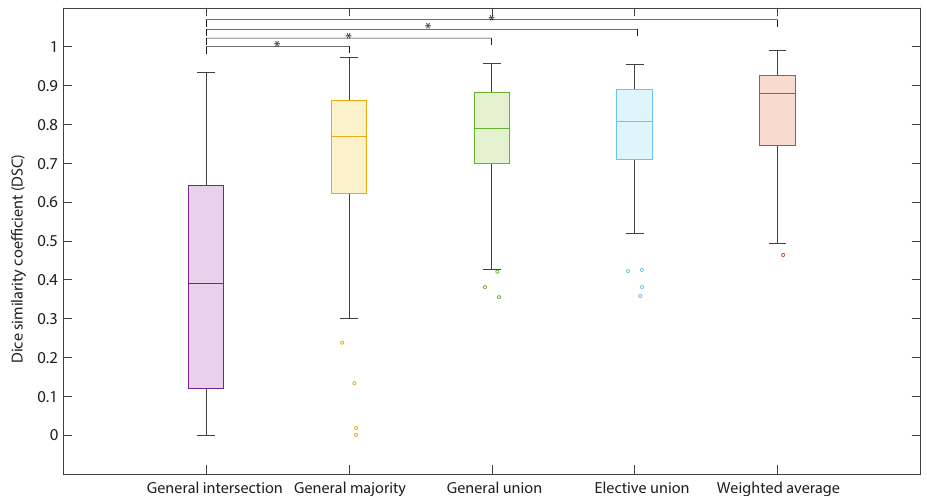
Figure 5. Boxplots demonstrating the segmentation performance of different ensemble approaches. The lines with an asterisk indicate a p -value <